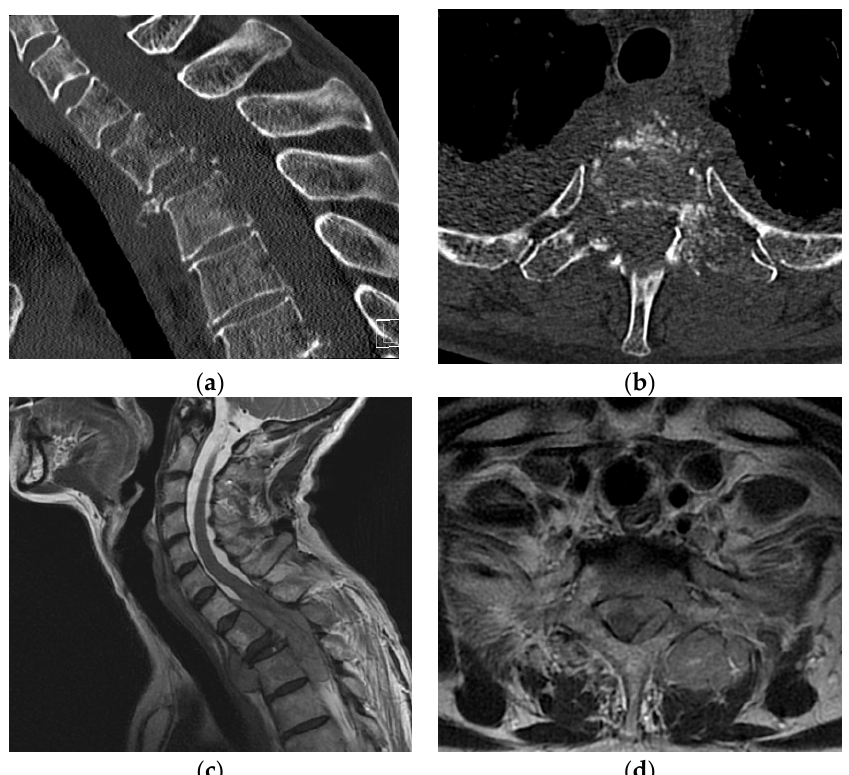
Figure 1. ( a – d ): Computed tomography in the sagittal ( a ) and transversal ( b ) plane of the cervical and upper thoracic spine of a 61-year-old female patient with breast cancer, who presented with progredient paralysis and gait disorder at our hospital. ( c ) Sagittal and ( d ) transversal view of T2-weighted magnetic resonance images showing complete spinal cord compression: ESCC grade 3 with no cerebrospinal fluid around the cord. ESCC, epidural spinal cord compression.